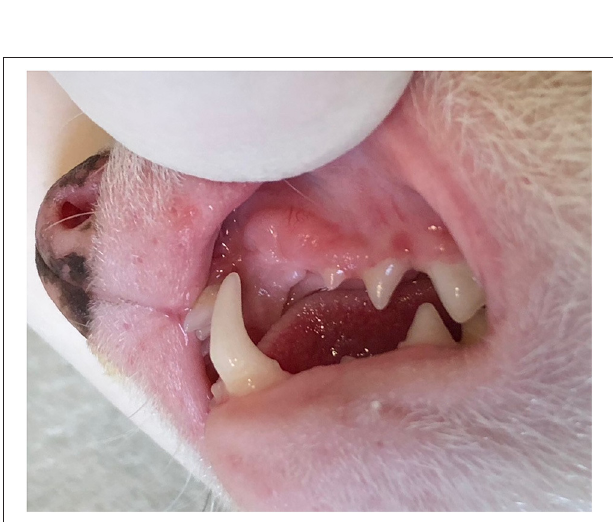
FIGURE 2 | Preoperative dental radiographs of the maxillary canine teeth (A,B) of a representative ferret included in this study. Lateral view (bisecting angle technique) of the left maxillary canine tooth affected by a complicated crown fracture (A) and healthy (note only mild abrasion on the caudal aspect and the tip of the crown) contralateral maxillary canine tooth (there is slight elongation of the canine tooth and an artifact at the left side of the image not interfering with the interpretation) (B) presented for comparison. No radiographic signs of endodontic disease are diagnosed associated with the fractured tooth (A) . However, photomicrograph of the dental pulp of the fractured left maxillary canine tooth (C) reveals pleocellular pulpits. The pulp stroma is densely infiltrated with macrophages, lymphocytes and neutrophils.